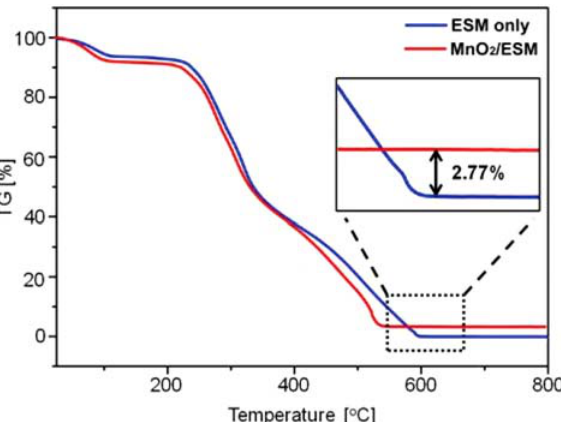
Figure 3. The TG curves of ESM and as-prepared MnO